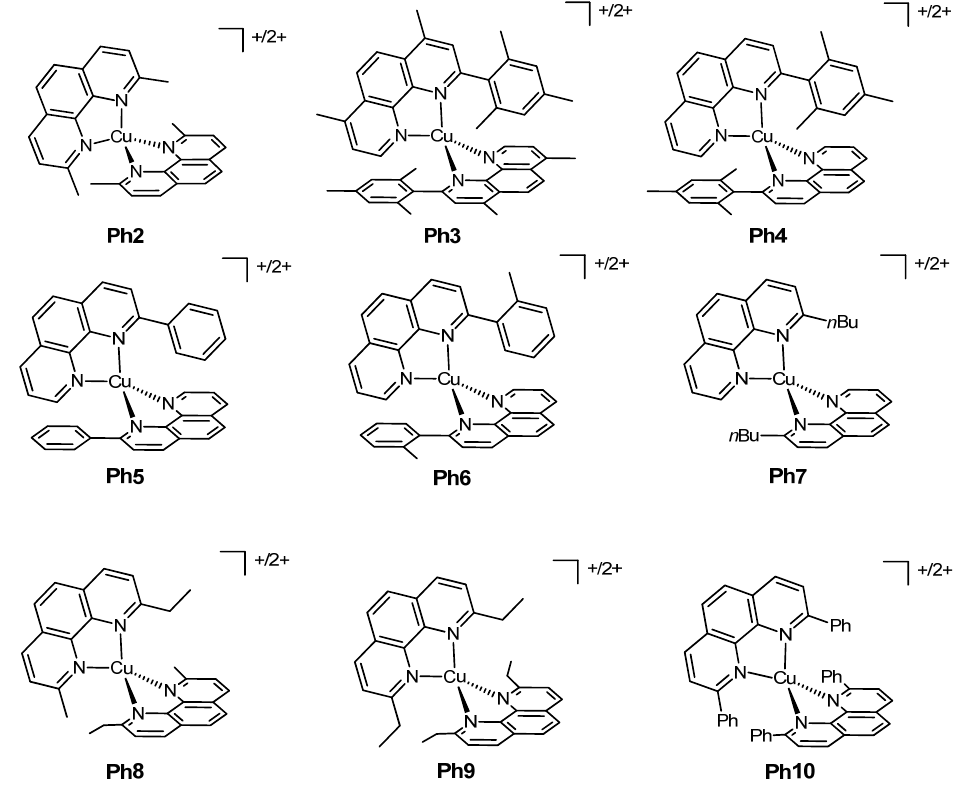
Figure 4. The copper complexes employed as redox mediators.